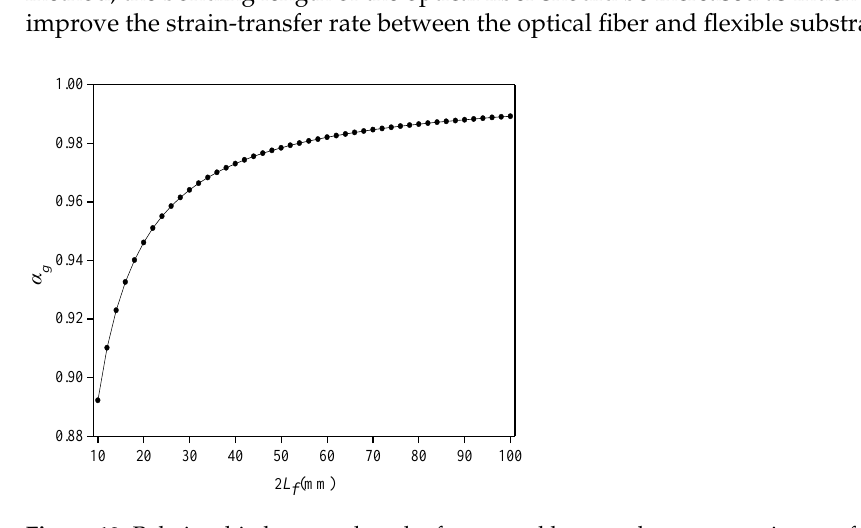
F L 2 R Figure 12. Schematic diagram of cantilever structure under force ( F ). '' ( ω R EI   (20) where E is the elastic modulus of the material, I is the moment of inertia, x is the distance between the strain point and fixed end, ω is the deflection, and the strain information of the flexible substrate can be realized from the sensing point. When the displacement de- formation occurs in the whole or local range of the geotechnical structure, because the